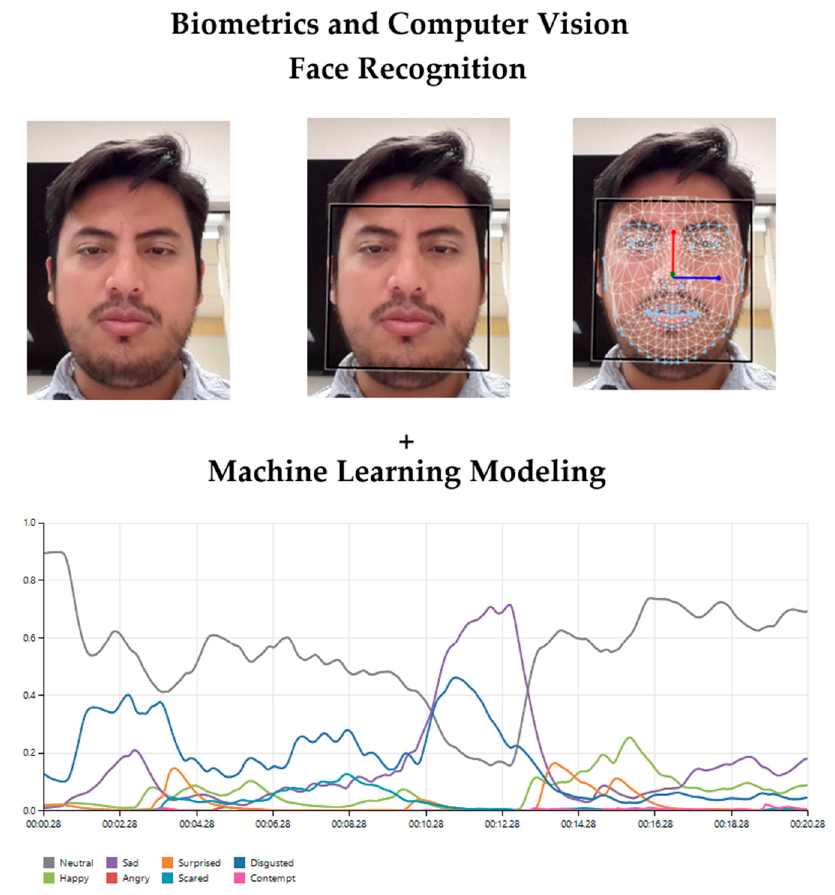
Figure 3. Diagram showing the techniques used in the face recognition to assess emotions from consumers; the example depicted was obtained using FaceReader™ software .